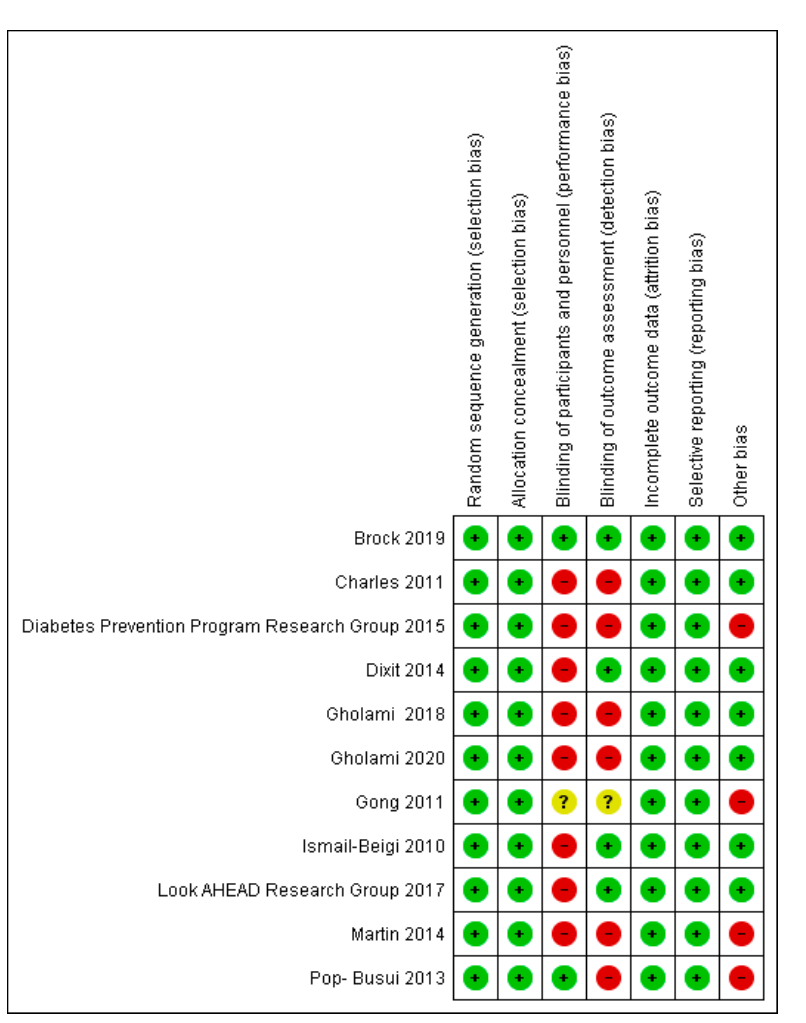
Figure 3. Risk of biases of the included studies [15,53–62], individual analysis. Green: low risk, yel- low: unclear risk, red: high risk.